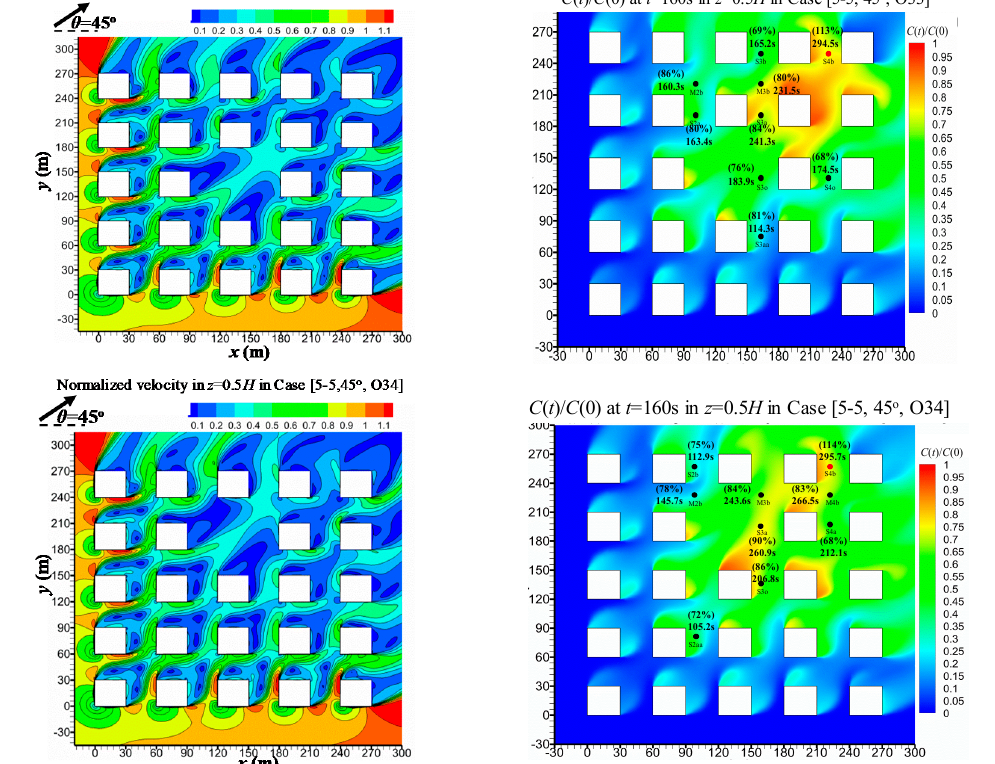
Figure 8. ( a ) 3D streamline in Case [5-5, 45 ° , O21] and Case [5-5, 45 ° , O33]; ( b ) the net ACH in all 24 test cases. ( c , d ) C(t)/C(0) at t = 160 s, age of air at various points, and normalized velocity at z = 0.5 H in Case [5-5, 45 ° ] and Case [5-5, 45 ° , Oij].